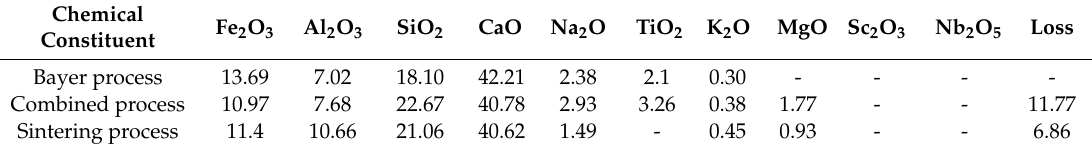
Table 3. Major chemical components of RM worldwide (mass fraction %). Reproduced with permission from [23], published by Elsevier Ltd.,